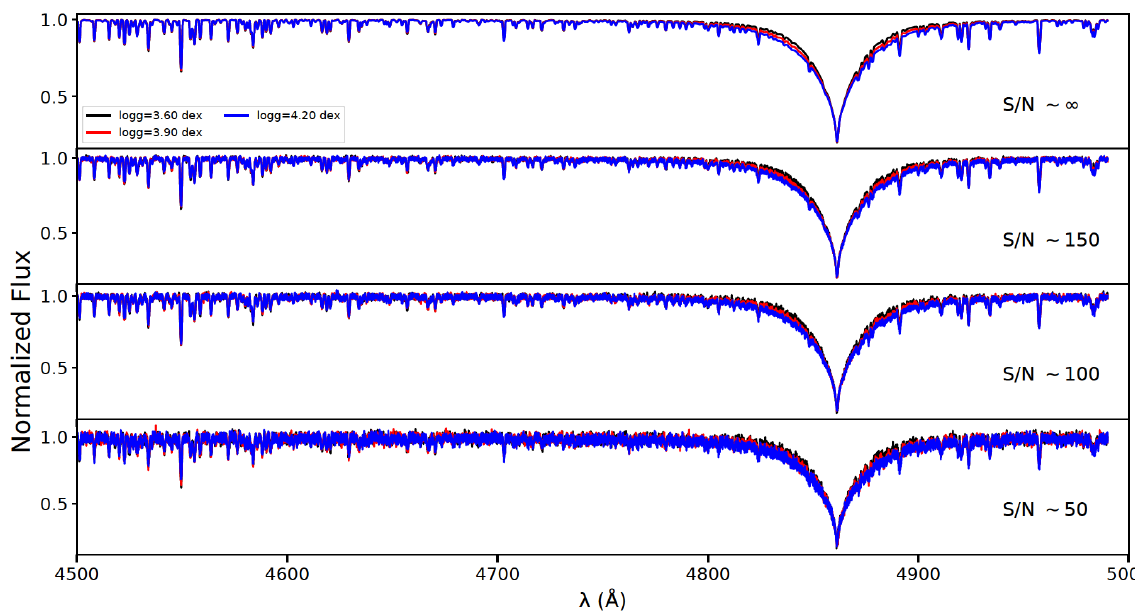
Figure 7. Same as for Figure 6 but for A stars having having [ T eff ,log g ,[ M / H ], v sin i ] of [8500 K,[3.60,3.90,4.20 dex], 0.0 dex, 40 kms −1 .